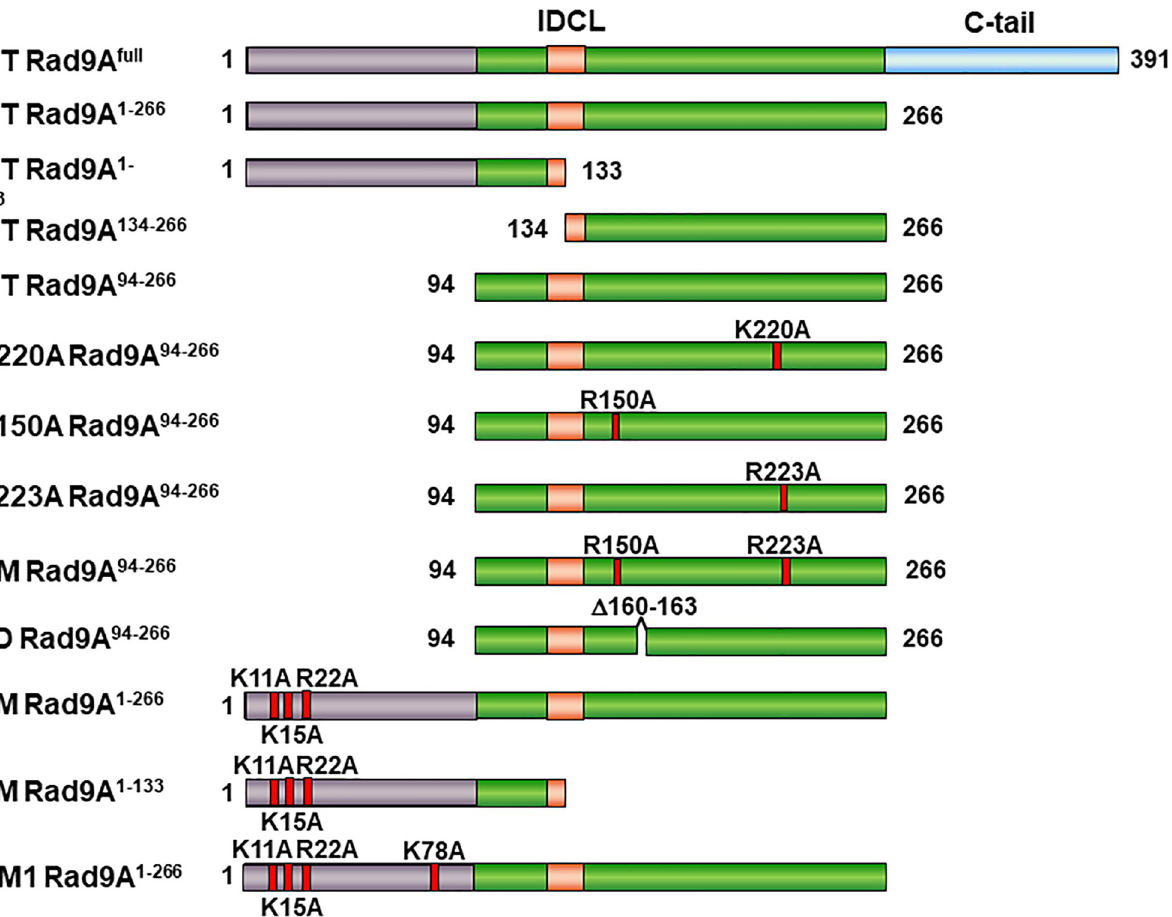
Fig 2. The hRad9A constructs and mutants used in DNA binding assay are depicted. Numbers represent residues of hRad9A. Residues 1–93 are colored dark violet and residues 94–266 are colored green except residues 125–140 (colored pink) which are the interdomain connecting loop (IDCL) between the N- and C-terminal globular domains. The C-terminal tail (C-tail) (colored blue) of hRad9A is not required for DNA binding.